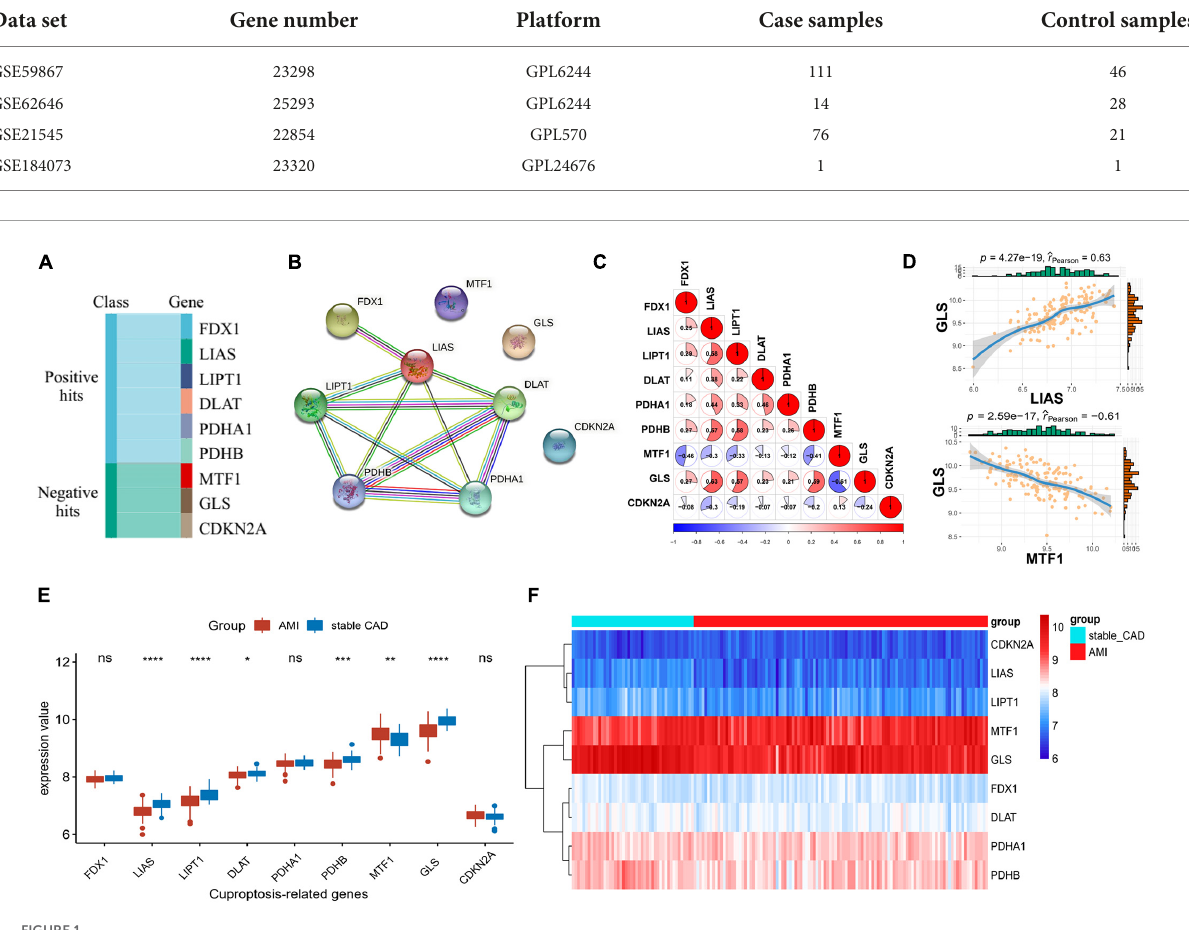
TABLE 1 Data sets implemented for analysis.